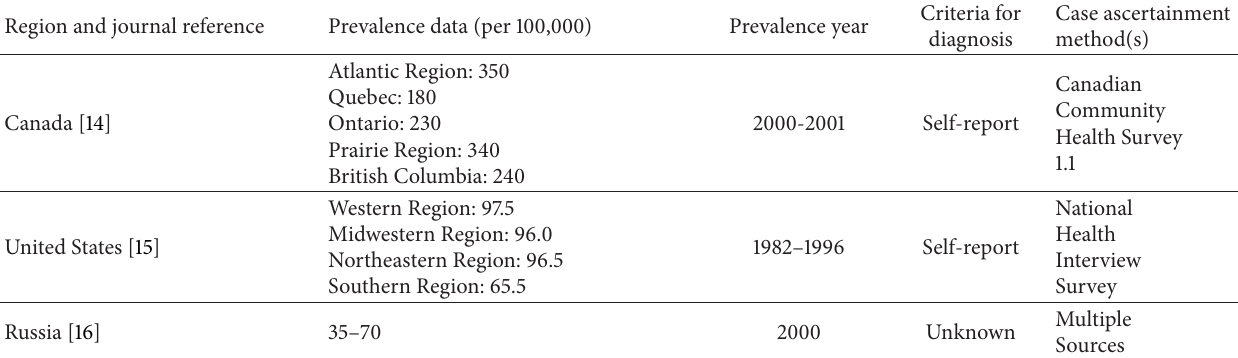
Table 1: Sample table of MS prevalence secondary sources and case ascertainment methods.